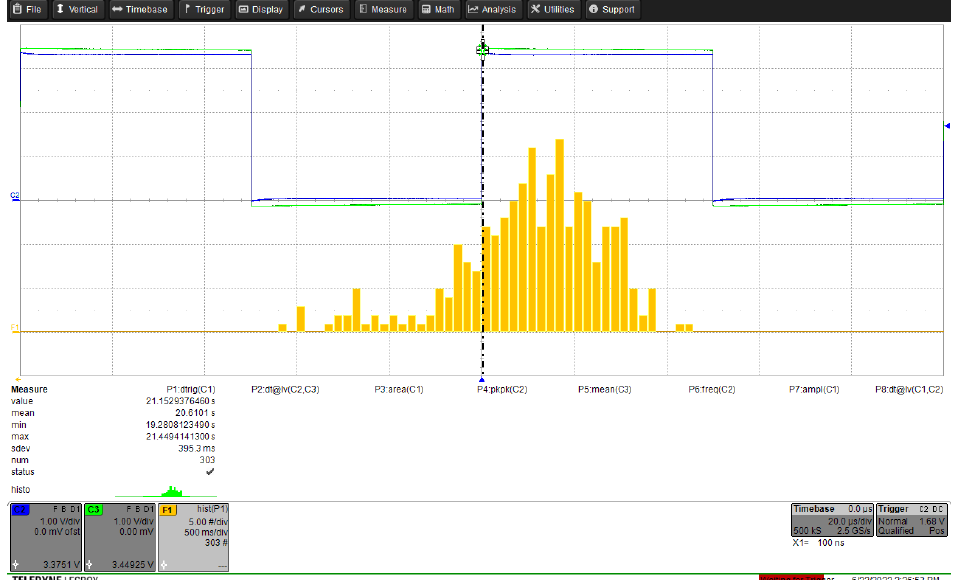
Figure 5. Experimental determination of realignment time statistics between the PWM signals of converter 2 and converter 1.